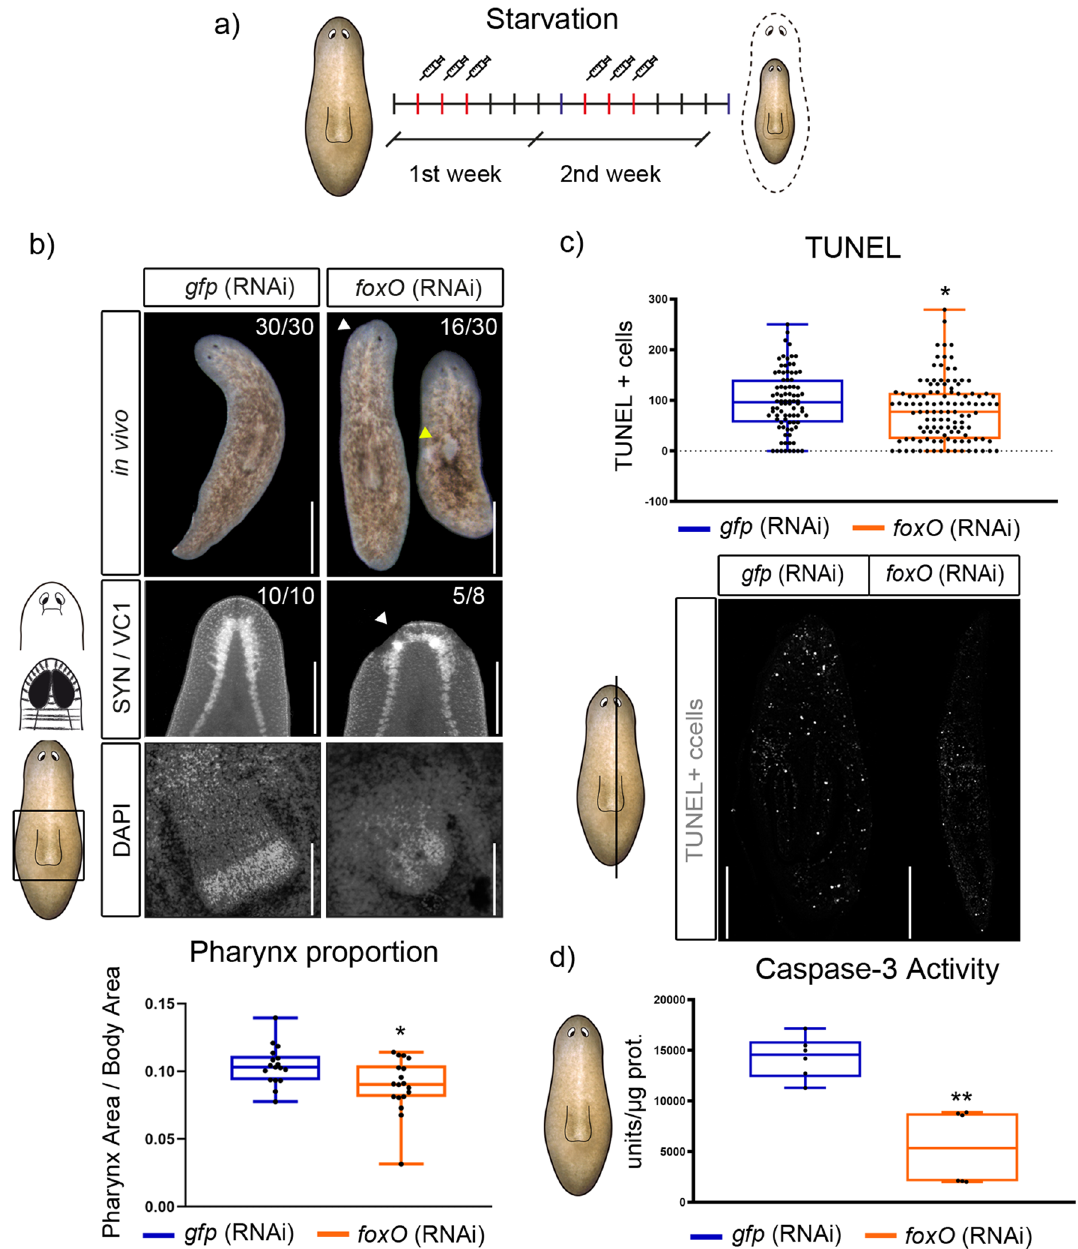
Figure 7. Starving foxO (RNAi) animals show tissue disruption and a reduction of cell death. ( a ) Schematic depicting RNAi procedure. ( b ) 50% of in vivo foxO knockdown animals presented unpigmented regions (white arrow), neural tissue disappearance (yellow arrow in synapsin immunoassayed animals, and pharynx size reduction, as shown by DAPI staining and relative size quantification (controls, n = 17; RNAi, n = 18; * P < 0.05). ( c ) Quantification of TUNEL + cells on transversal sections show a reduction of positive cells in foxO (RNAi) animals compared to controls (controls, n = 86; RNAi, n = 117; * P < 0.05). ( d ) Quantification of caspase-3 activity in foxO (RNAi) animals and controls shows cell death reduction (controls, n > 6; RNAi, n > 6; ** P < 0.01). Scale bars: b up and mid = 100 µm and down = 10 µm; c = 100